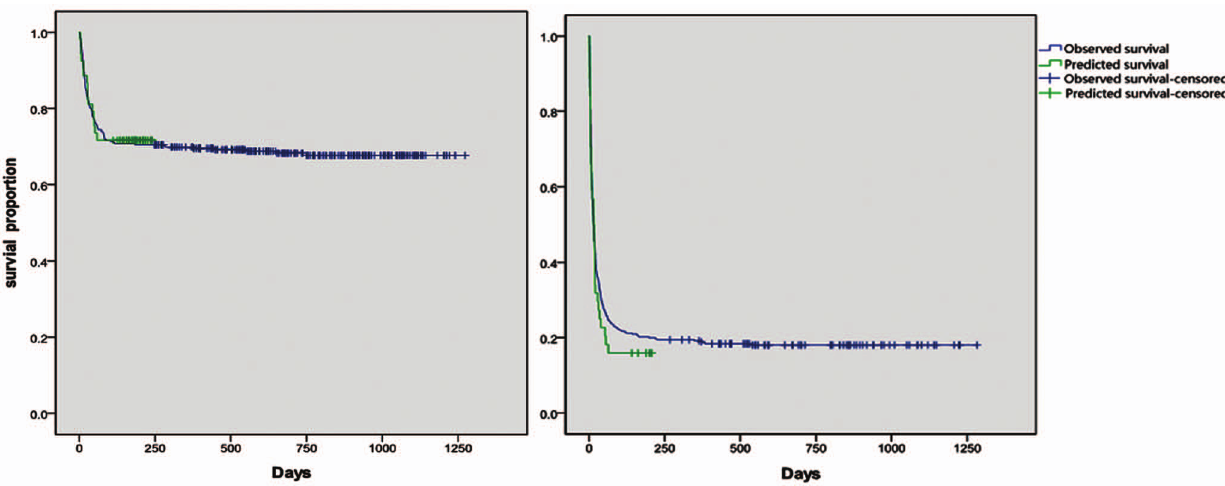
Figure 4. Survival of 97 independent patients with ACLF or pre-ACLF from the validation cohort who were stratified according to their risk score as either low risk (n=53; left panel) or high risk (n=44; right panel). The median survival in the high-risk group was less than 12 weeks (R . 2.37). In the low-risk group, the median predicted survival was more than 12 weeks (R , 2.37). Actual (Kaplan–Meier) and expected survival using the new prognostic model were compared by the one sample log rank test. For the low-risk and high-risk patients, the observed and expected survival rates were similar (P=0.898 and P=0.442, respectively).